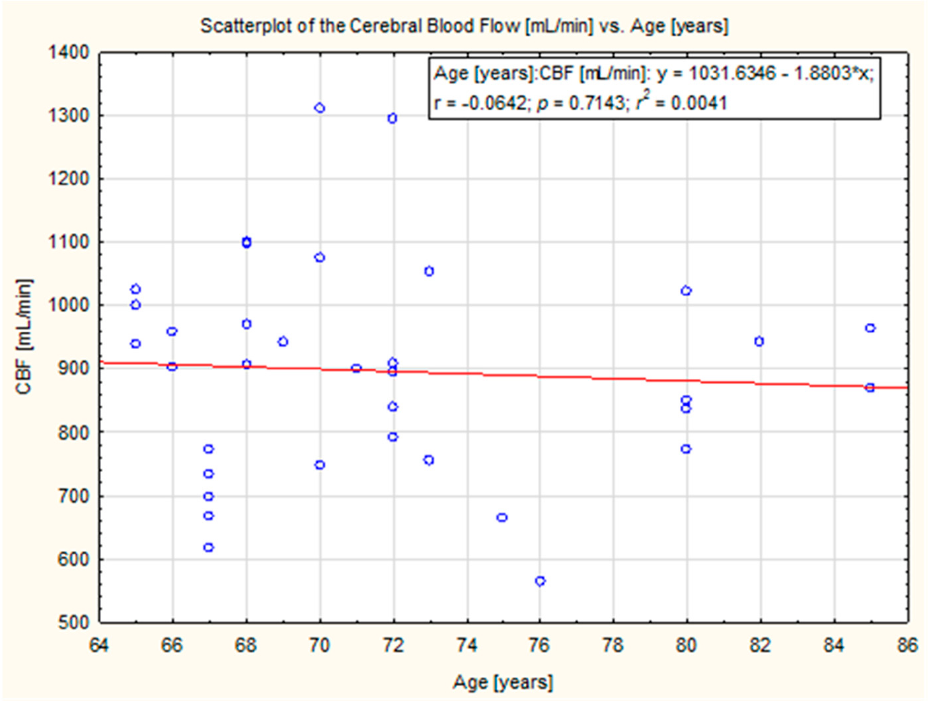
Figure 8. Scatter plot of cerebral blood flow volume and age (y = 1031.6346—1.8803*x). No correlation was observed ( p = 0.71).